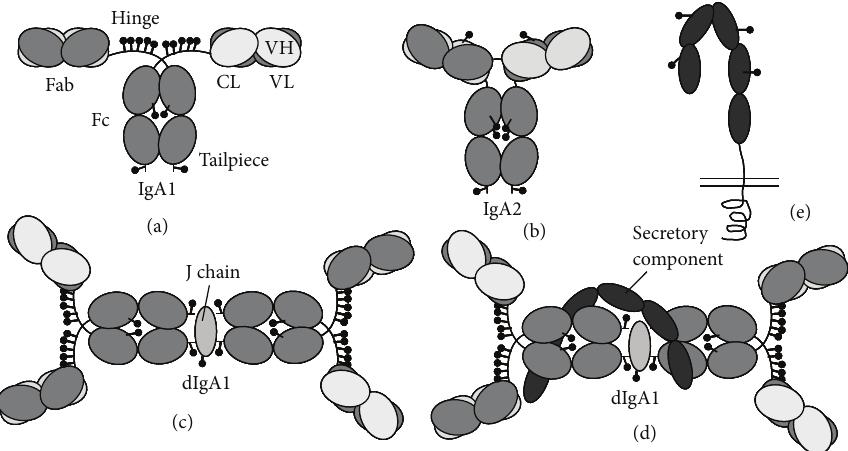
Figure 1: Human IgA structure. Schematic diagrams of (a) IgA subclass 1 (IgA1), (b) IgA2, (c) dimeric IgA1 (dIgA1), (d) secretory IgA1, and (e) polymeric immunoglobulin receptor (pIgR) (adapted from